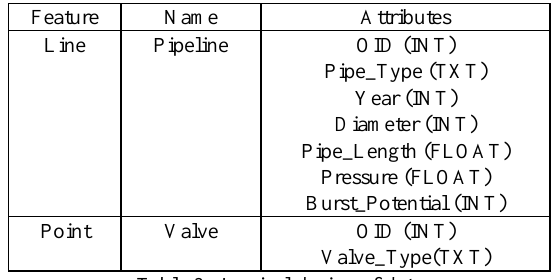
Table 3. Logical design of